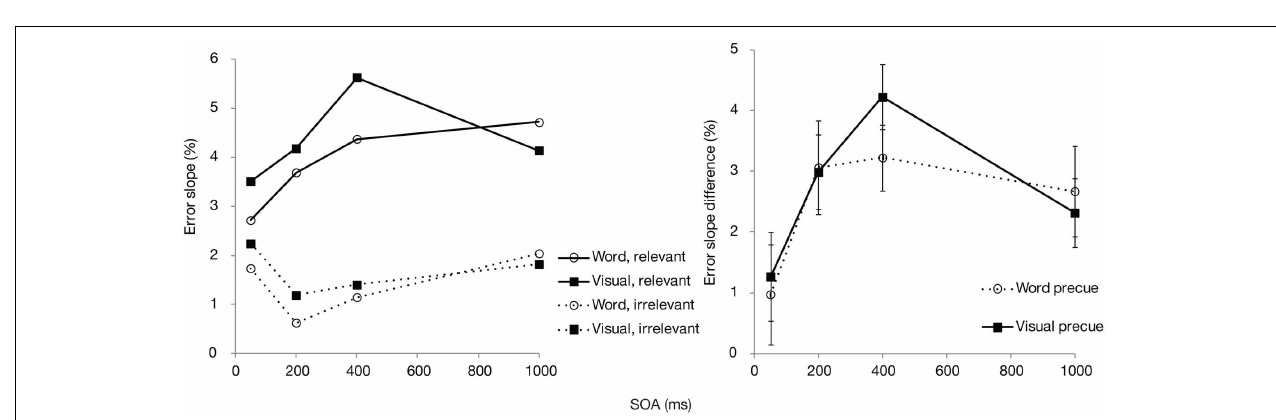
FIGURE 6 | Experiment 2: Mean error slopes for the relevant and irrelevant set, and their differences, plotted as a function of precue type and SOA.